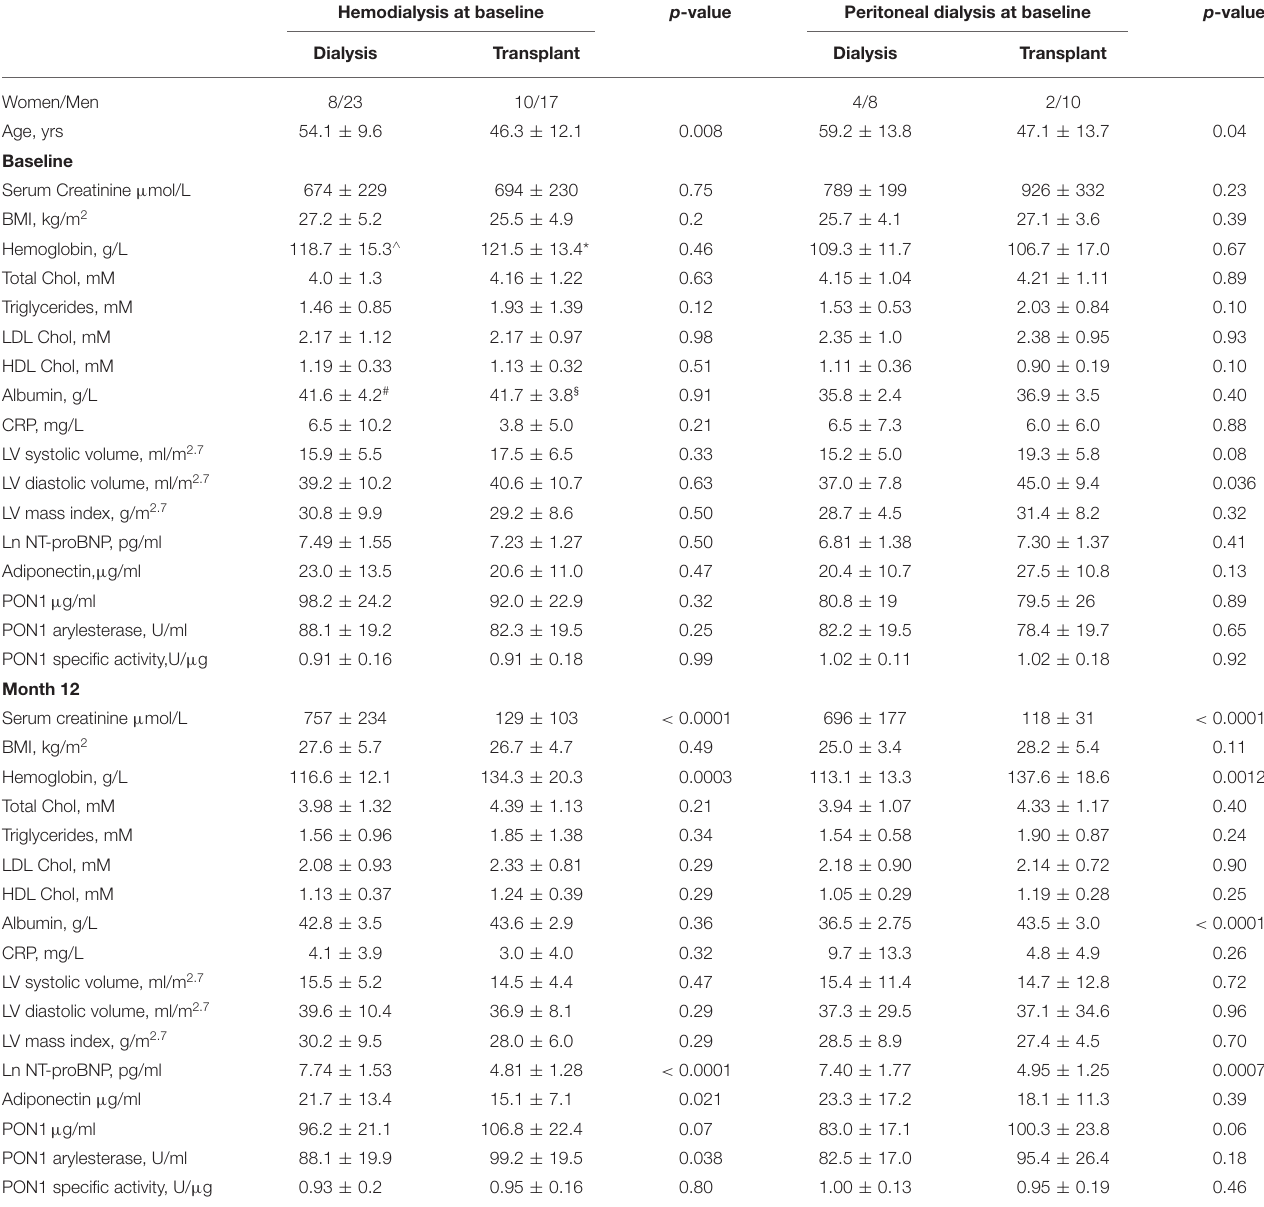
TABLE 1 | Characteristics of study subjects by treatment group and baseline dialysis modality. Hemodialysis at baseline p -value Peritoneal dialysis at baseline p -value Dialysis Transplant Dialysis Transplant